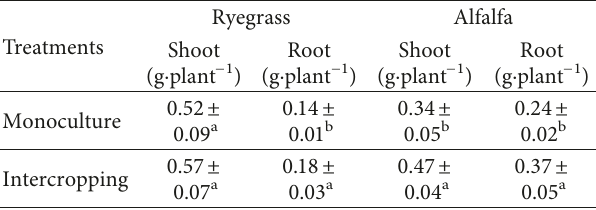
Table 2: The biomass of ryegrass and alfalfa with different treatments. Ryegrass Treatments